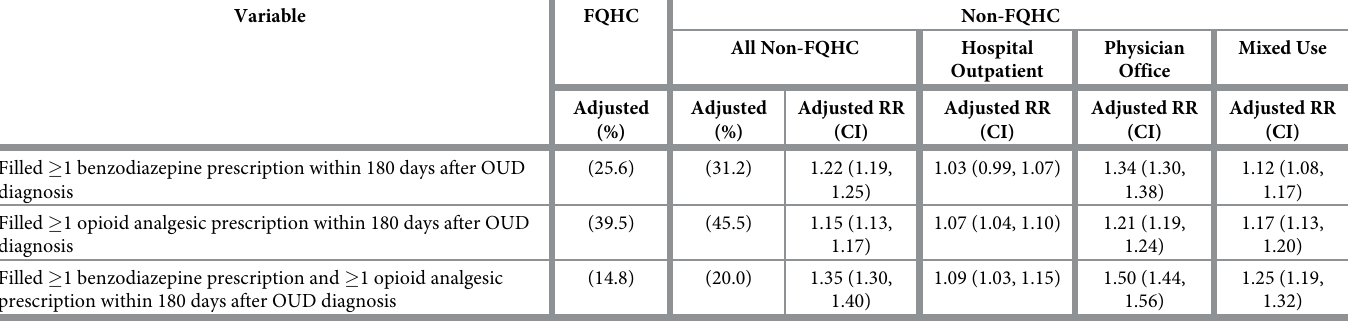
Table 4. Opioid analgesic and benzodiazepine prescribing among patients with at least six months of continuous Medicaid enrollment after OUD diagnosis by pri- mary care setting: United States,